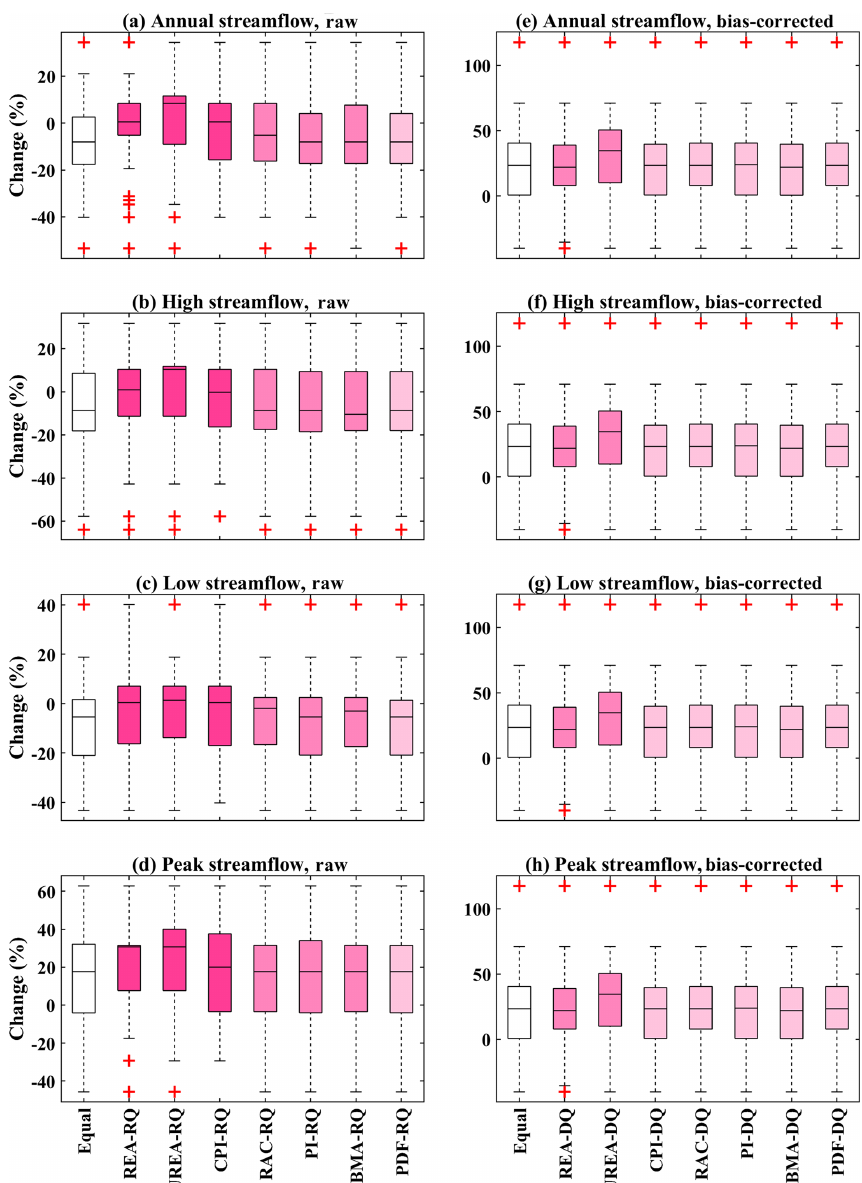
Figure 7. Box plot of changes in four hydrological indices calculated by raw or bias-corrected GCM-simulated streamflows in the Xiangjiang watershed. The changes of hydrological variables were sampled through the Monte Carlo approach based on the weights calculated using raw ( R Q ) or bias-corrected ( D Q ) GCM-simulated streamflows. (The depth of pink represents the level of inequality of the